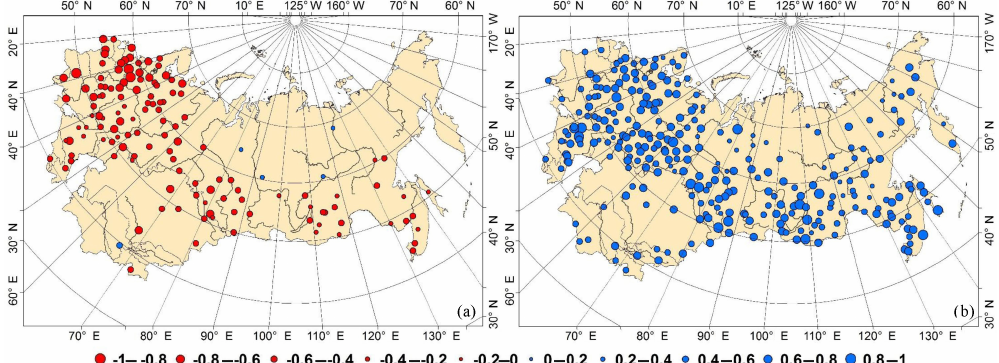
Figure 11. Spatial distributions of partial correlation coefficients between long-term mean annual snow depth and air temperature (a) and be- tween long-term mean annual snow depth and snowfall (b) from November through March across the former USSR. The coefficients reaching to the 95% confidence level are displayed. Red circles represent a negative relationship, and blue circles indicate a positive